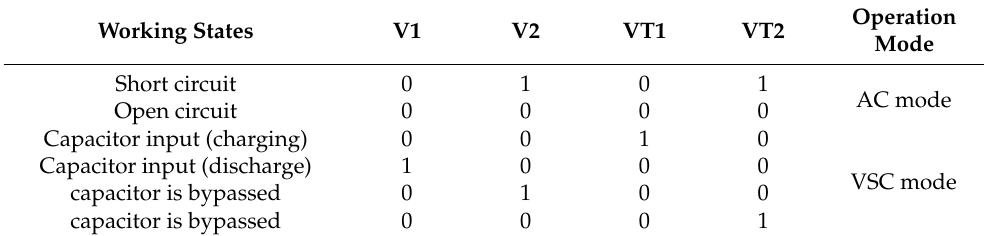
Table 2. Submodule working states.